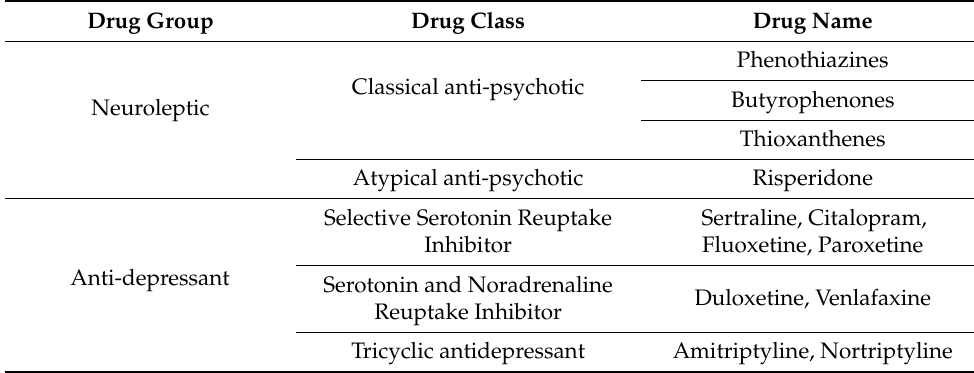
Table 1. Summary of drug causes of